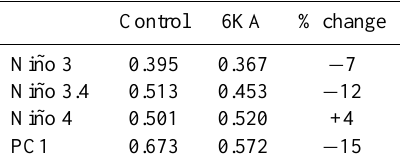
Table 1. El Ni˜no-Southern Oscillation statistics for years 201–1200 of experiments CONTROL and 6KA: The standard deviation